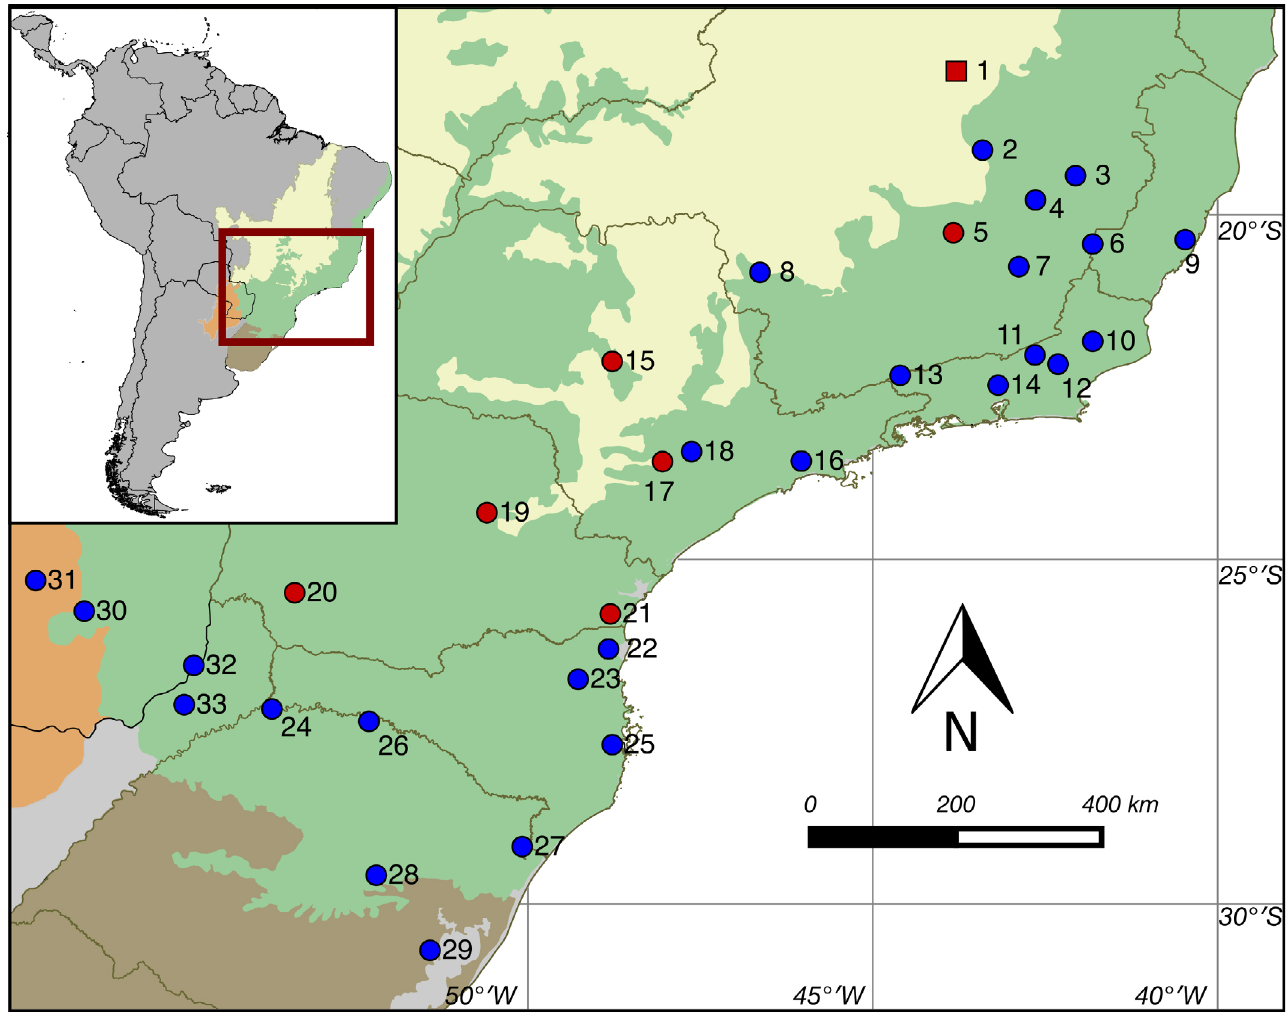
Figure 5. Collecting localities of Euryzygomatomys spinosus in Brazil, Paraguay and Argentina. Blue dots represent published records; red dots show new records based on specimens examined from museum collections and published data; red square (locality 1) shows our new record from Sempre Vivas National Park, in the Brazilian Cerrado. Numbers correspond to localities listed in Table 2. Green area corresponds to the Atlantic Forest, yellow area to the Cerrado, brown area to the Pampas and orange area to the Chaco Humedo. Map based on Olson et al. (2001) and IBGE